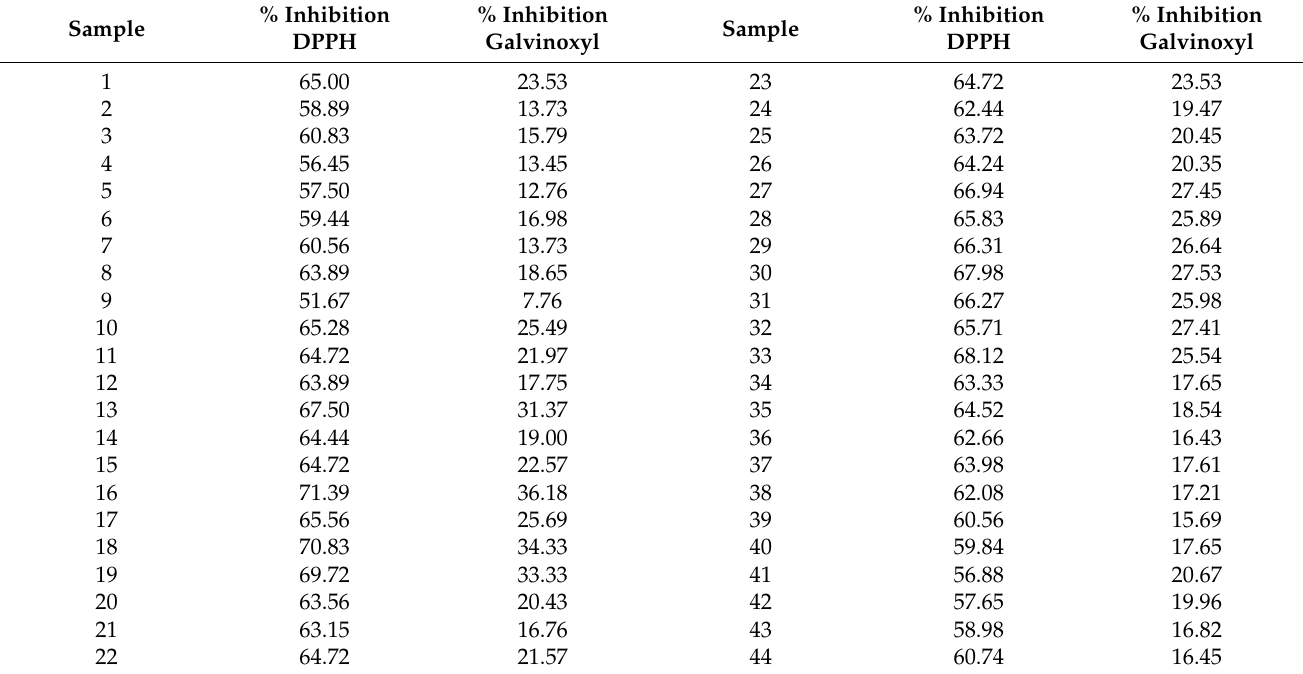
Table 3. Antioxidant activity of oil samples studied expressed as % inhibition of the free radicals DPPH or galvinoxyl.